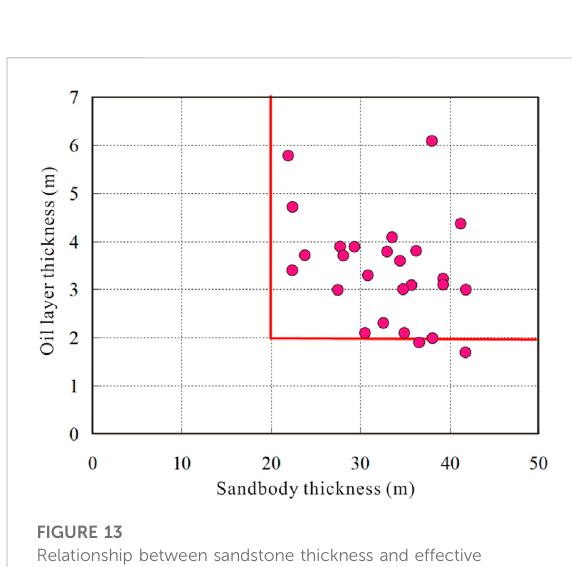
FIGURE 13 Relationship between sandstone thickness and effective thickness of the Chang 1 Member in the study